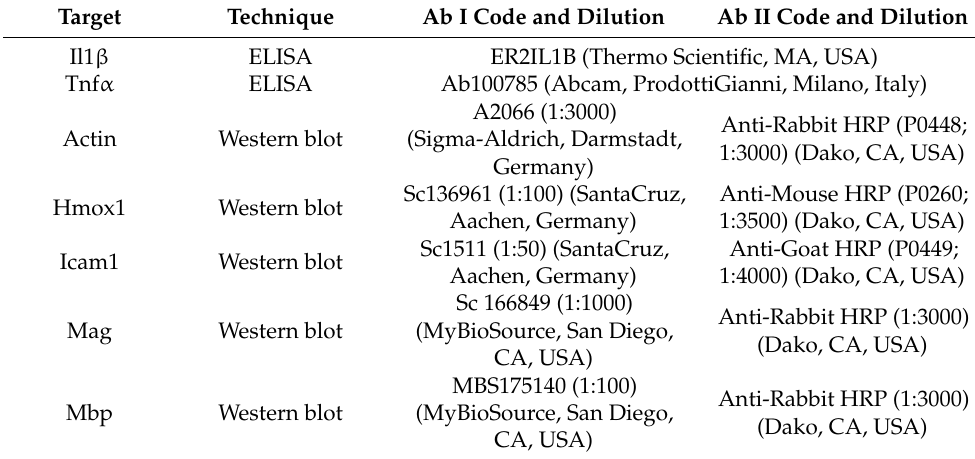
Table 2. Antibodies and ELISA kit